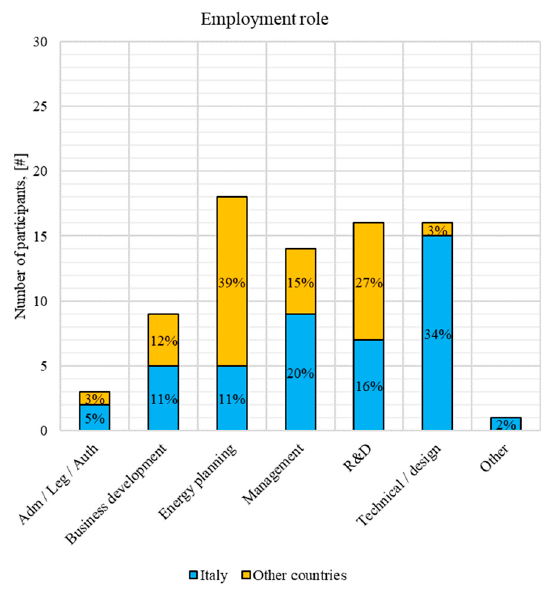
Figure 4. Number of survey participants as a function of the employment role.